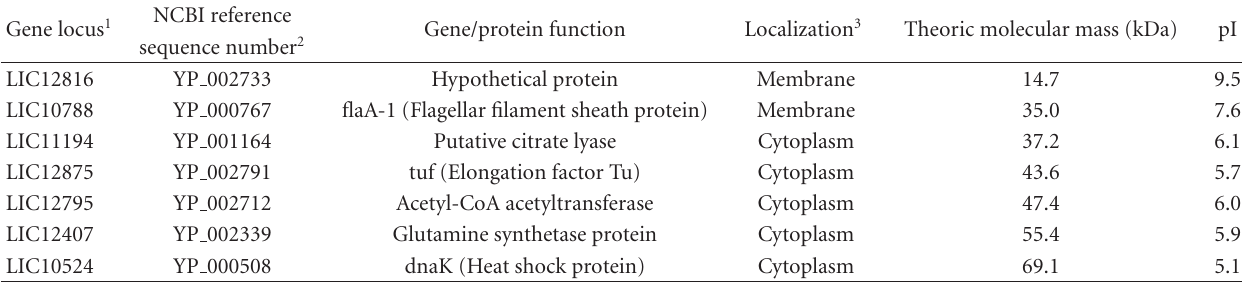
Table 2: L . interrogans PLG-binding proteins identified by MALDI-TOF mass spectrometry. The proteins are identified as the genomic nomenclature (LIC: Leptospira interrogans serovar Copenhageni), and are listed and respective NCBI reference sequence,